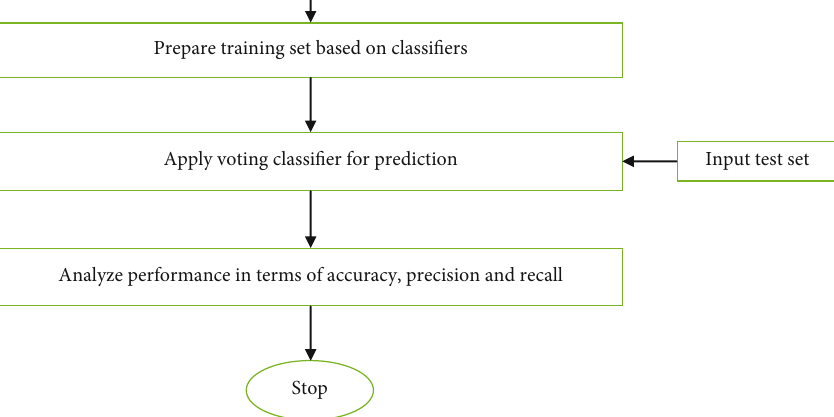
Figure 2: Ensemble classi fi er 1